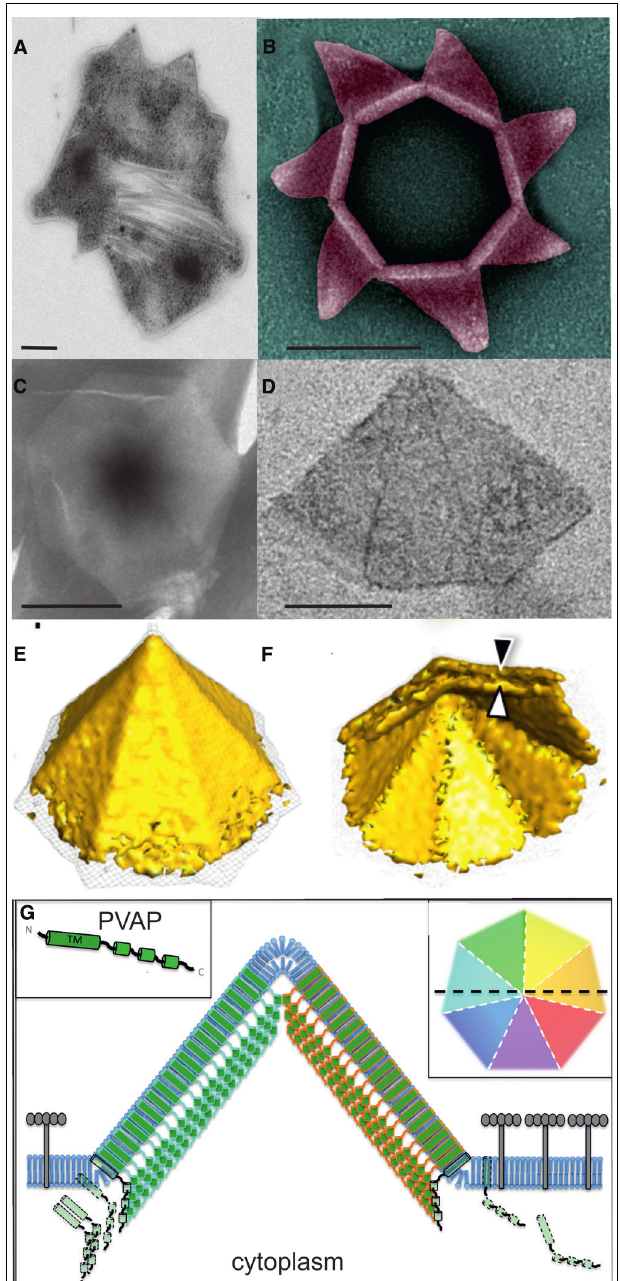
FIGURE 2 | Remarkable archaeal virion egress structure. (A) Scanning electron micrograph of an SIRV2 infected S. islandicus cell displaying several VAPs. (B) Transmission electron micrographs of isolated VAPs in closed and (C) open conformation. (D) Solid representation of VAP obtained by subtomogram averaging displaying the (E) outside and (F) interior. (G) Model of VAP formation. Adapted from (Bize et al., 2009; Quax et al., 2011; Daum et al., 2014). Scale bar, 100